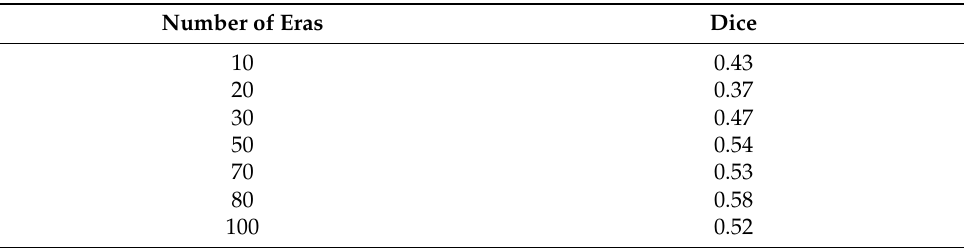
Table 1. Magnitude of the average value of Sørensen–Dice coe ffi cient depending on the number of epochs of training.